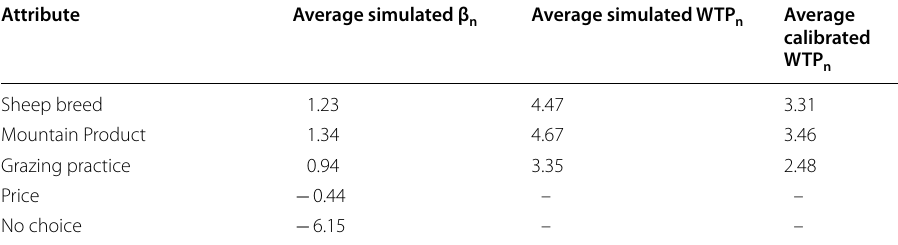
Table 5 Means of the simulated individual parameters and marginal WTPs